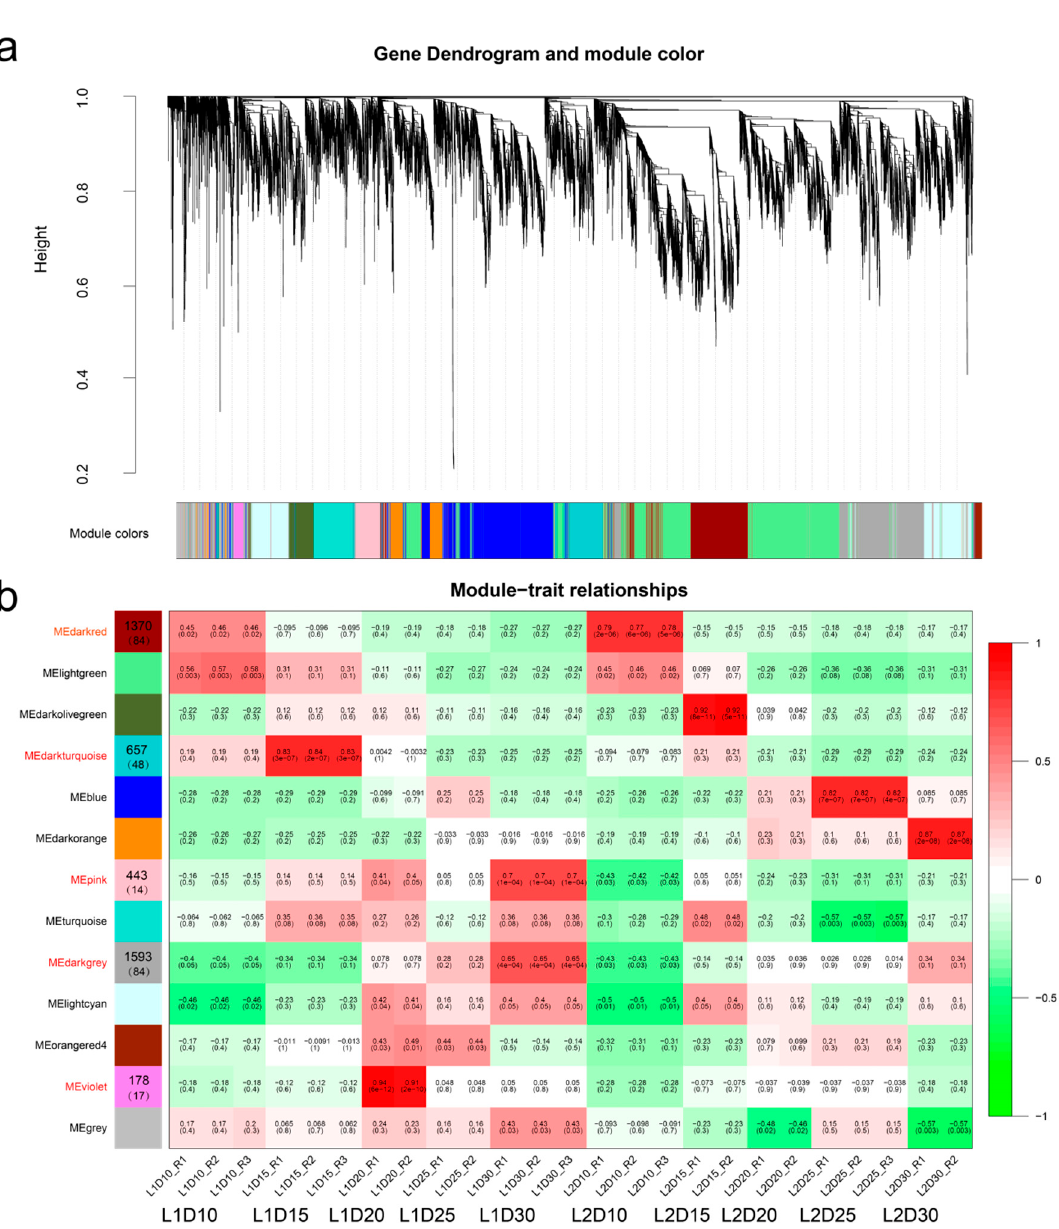
Figure 6. Weighted gene co-expression network analysis (WGCNA) of differentially expressed genes (DEGs) in L1 and L2 at five time points of fiber development. ( a ) Hierarchical dendrogram showing co-expression modules identified by WGCNA. Each leaf in the tree represents one gene. The major tree was divided into 13 modules based on calculation of eigengenes; each module is highlighted in a different color. ( b ) Module–sample relationships. Each row represents a module, and the correlation coefficient and the e-value are shown in each square. Each column corresponds to a sample tissue and replication (R). The number of genes and transcription factors enriched in the module are shown in the left module squares and parentheses, respectively. The modules names in red were highly associated with the high-quality fiber line (L1).